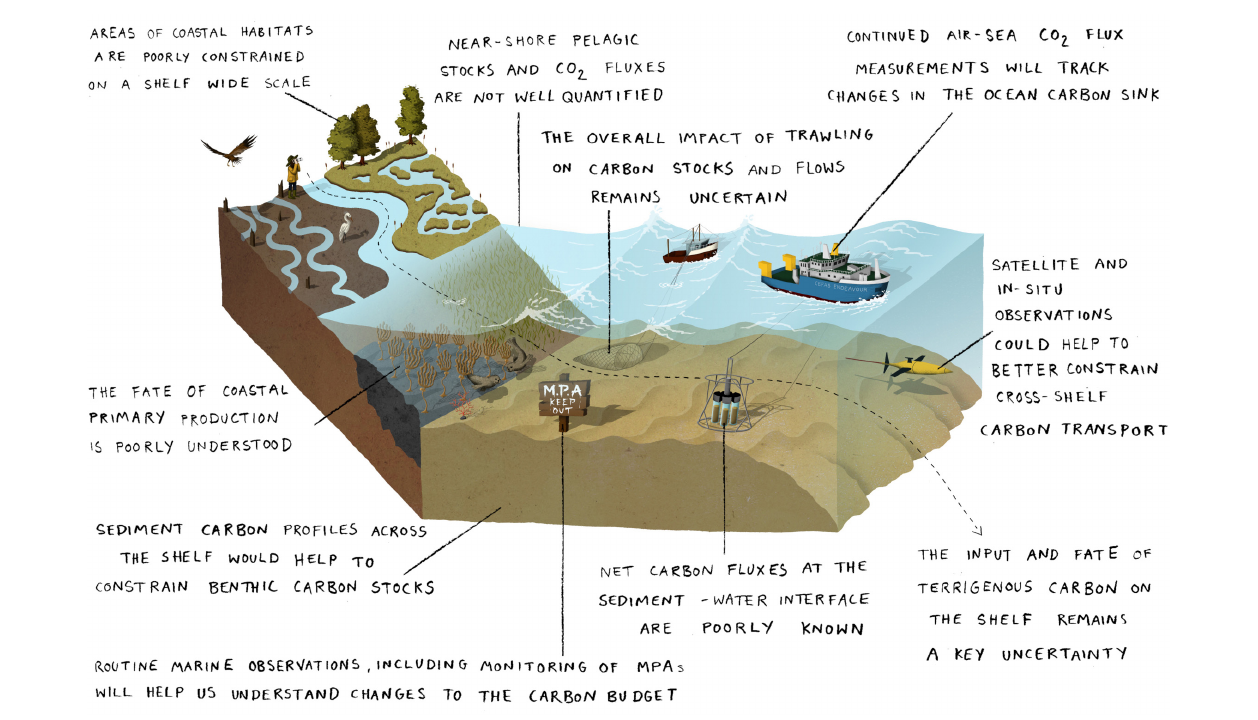
FIGURE 5 | The key knowledge gaps and research priorities in the contemporary carbon budget for the north west European